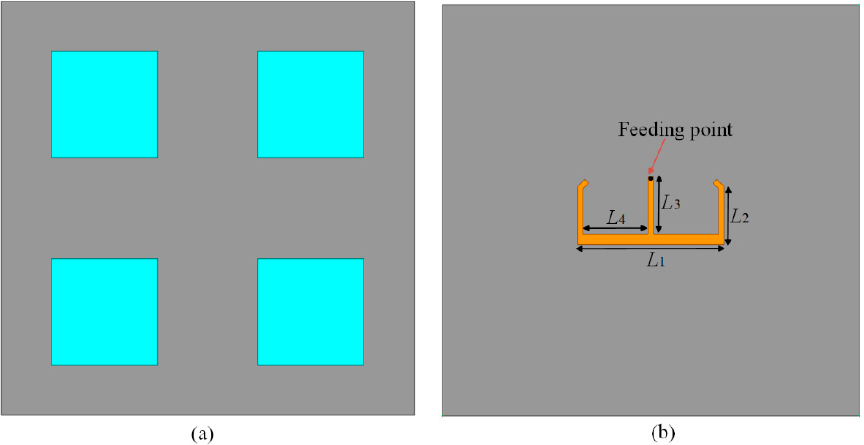
Figure 2. ( a ) Top view of the proposed antenna with one port. ( b ) Back-side view of the proposed antenna with one port.